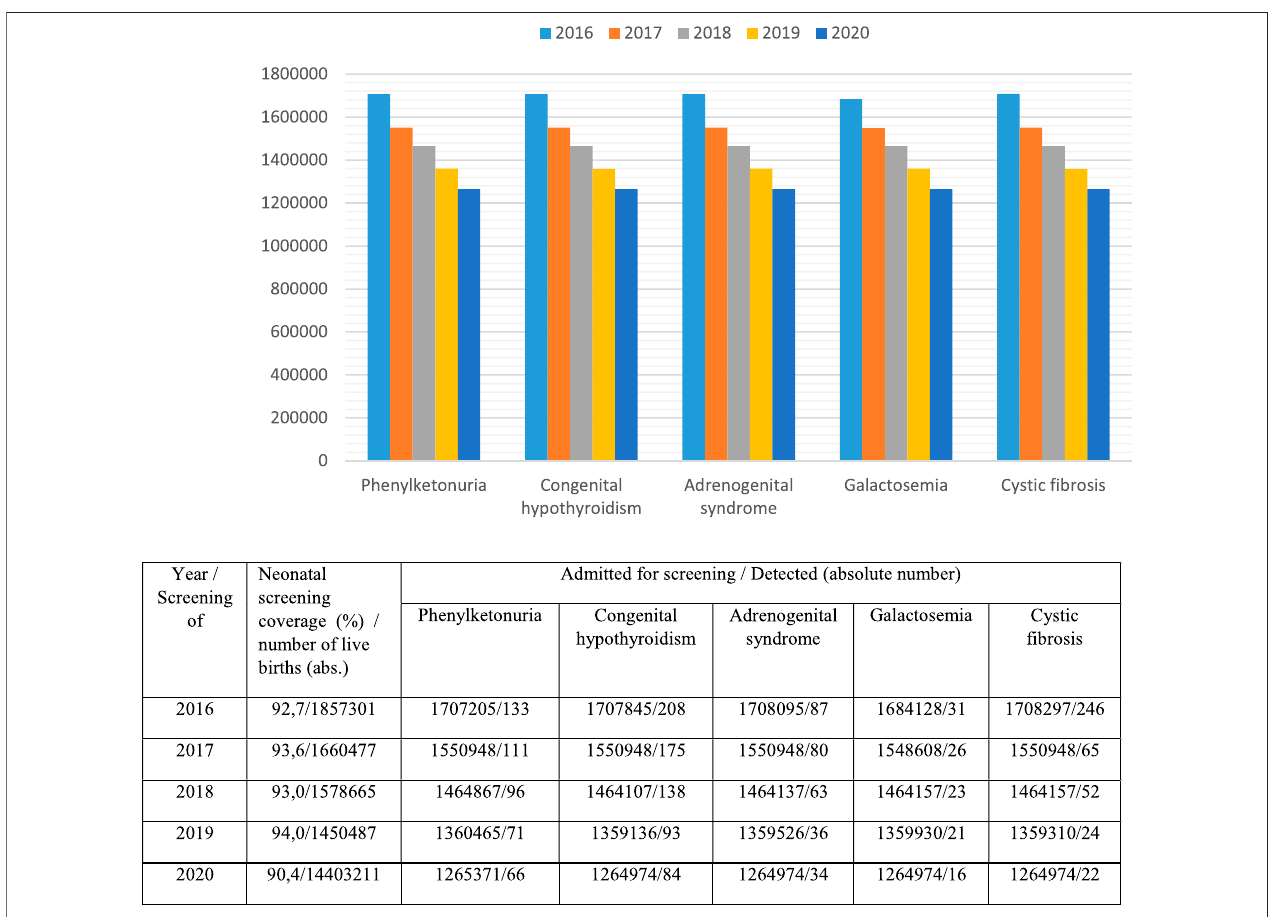
FIGURE 3 | National neonatal screening coverage (2016 –